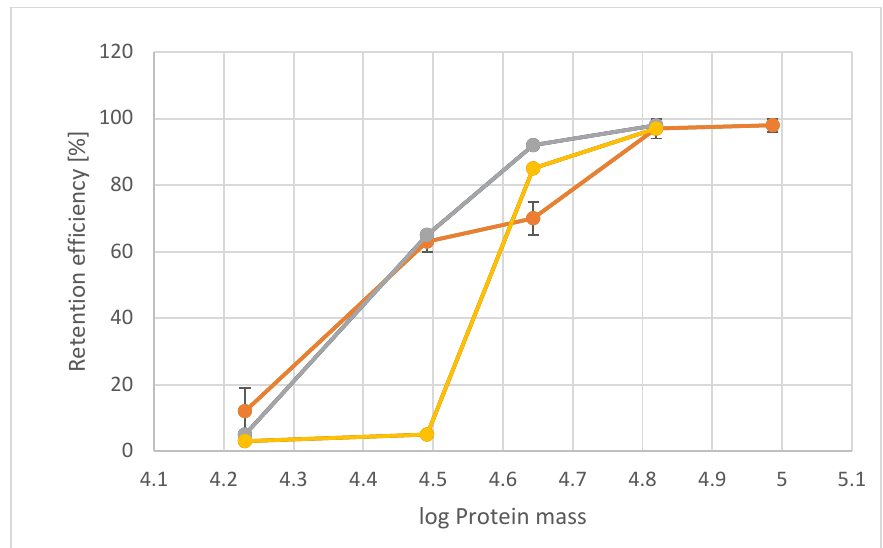
Figure 5. Retention efficiency of Saccharolobus solfataricus P2 fragments deposited on microfilter 2 (SSOMF2) (orange); B. stearothermophilus pV72 (yellow) and C. thermohydrosulfuricum L111-69 (gray). The proteins with increasing molecular mass are myoglobin (17 kDa), carbonic anhydrase (31 kDa), ovalbumin (43 kDa; for bacterial SLP material), horseradish peroxidase (44 kDa; for SSOMF2), bovine serum albumin (66 kDa), and amyloglucosidase (97 kDa) (n ≥ 4). Data for the retention curve of B. stearothermophilus pV72 and C. thermohydrosulfuricum L111-69 are taken from Ref. [25]. Table 1. Molecular mass (M r ), molecular size, and retention efficiency of Saccharolobus solfataricus P2 fragments deposited on microfilter 1 (SSOMF1) and 2 (SSOMF2), respectively , for selected proteins.